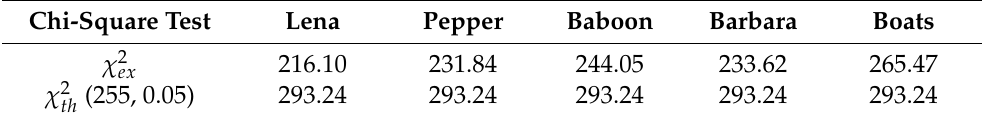
Table 7. Chi-square results on the histograms tested.